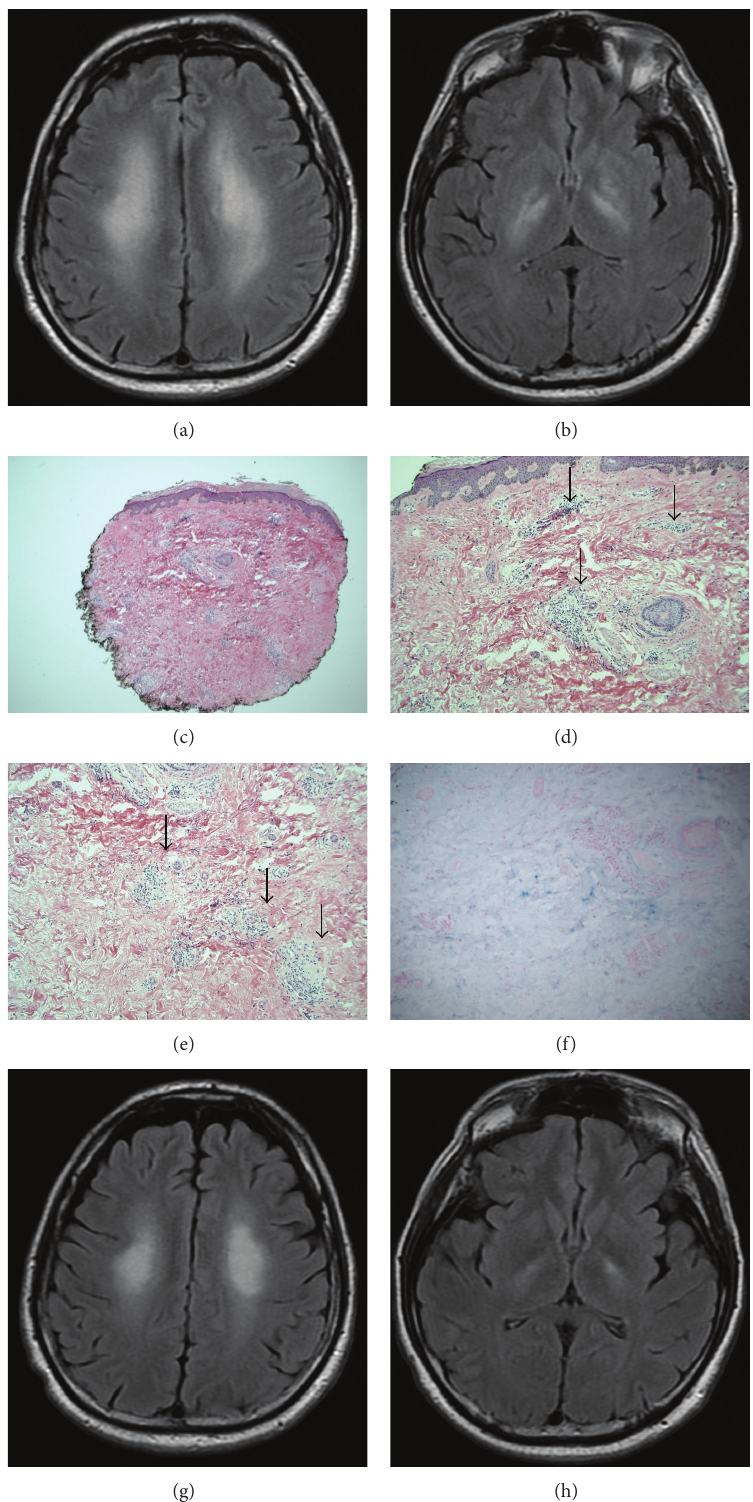
Figure 1: 50-year-old male presenting with diffuse, confluent leukoencephalopathy and subacute parkinsonism. Axial brain MRI FLAIR sequence on initial presentation showing extensive confluent symmetric hyperintensities ((a) and (b)). Gross skin punch biopsy from right knee (c) shows superficial ((d), arrows) and deep perivascular dermatitis ((e), arrows) with focally increased dermal mucin highlighted by Alcian blue stain (f). Repeat axial brain MRI FLAIR sequence after 5 months demonstrating radiographic improvement following immunosuppressive therapy ((g) and